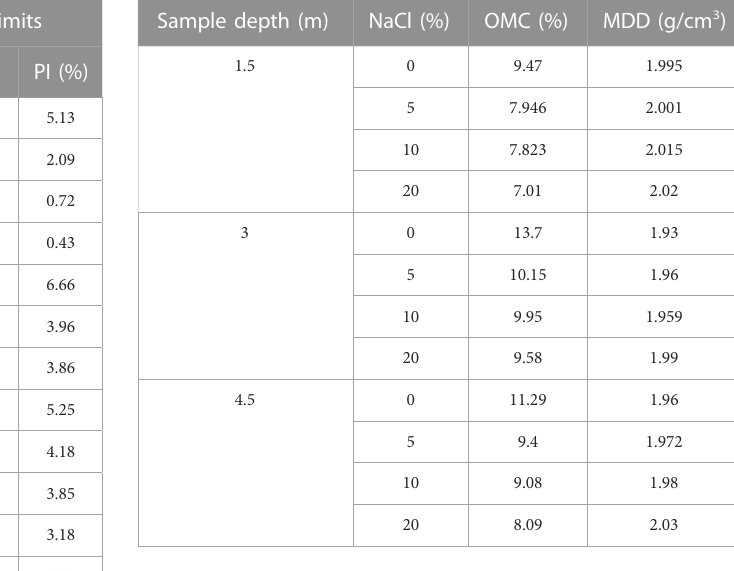
TABLE 5 Atterberg limits results for different percentages of NaCl. TABLE 6 Compaction test results for natural and treated soil